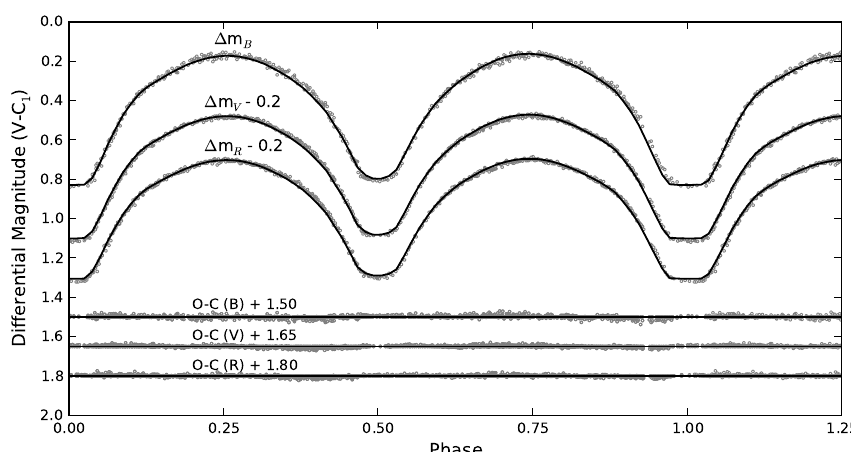
Fig. 4. Observational (circles) and synthetic (solid lines) BVR light curves for BB Peg obtained on 2009 August 8 and 10. The rest is the same as in Figure 2.